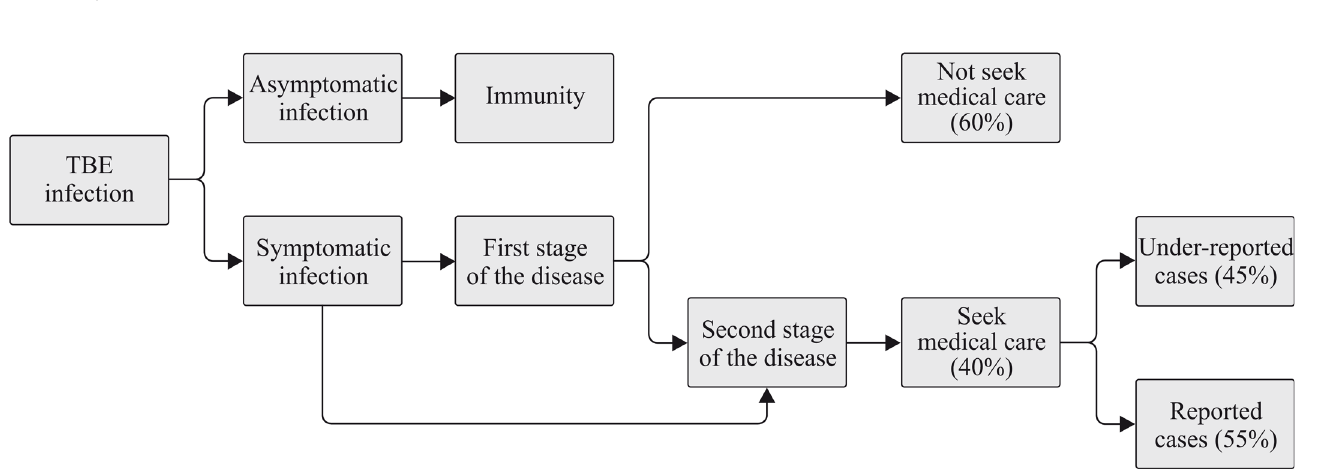
Fig 1. Schematic presentation of disease progression, used to estimate the factors β r, β a and consequently γ ; with γ (4.5) to correct under- estimation of the reported number of cases with the acute disease of the second stage (n ra ) resulting from the product of a factor β a (100/40 = 2.5) to correct for under-ascertainment and a factor β r (100/55 = 1.8) to correct for